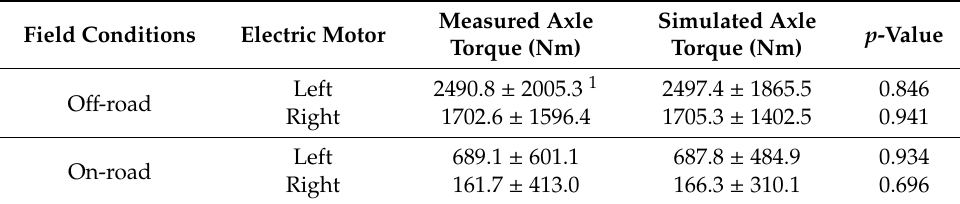
Table 2. Comparison of axle torque between measured and simulated results based on the operation conditions at 10 km/h.